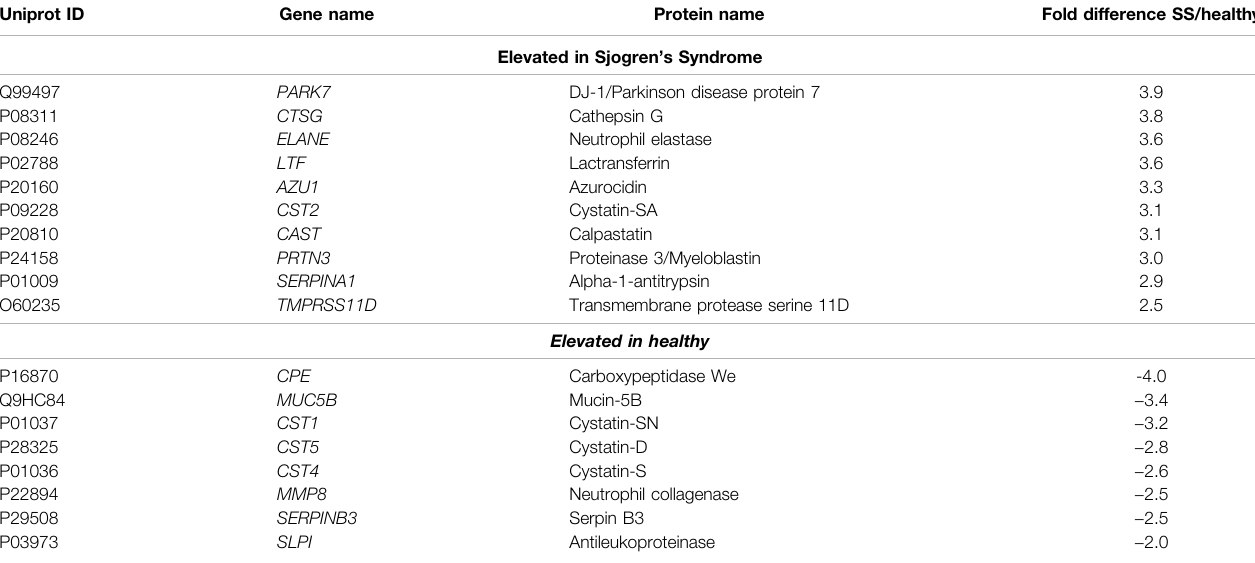
TABLE 3 | Proteases and protease inhibitors signi fi cantly elevated in Sjogren ’ s Syndrome (SS) saliva over healthy controls. Uniprot